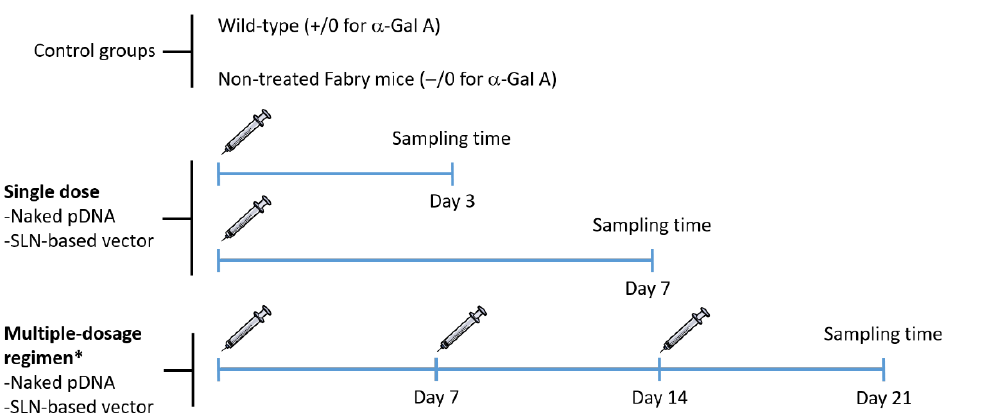
Figure 1. Schematic representation of the experimental design of the administration and sampling protocol. * One dose per week for 3 weeks. α-Gal A: α-Galactosidase A; pDNA: plasmid DNA; SLN: solid lipid nanoparticle.